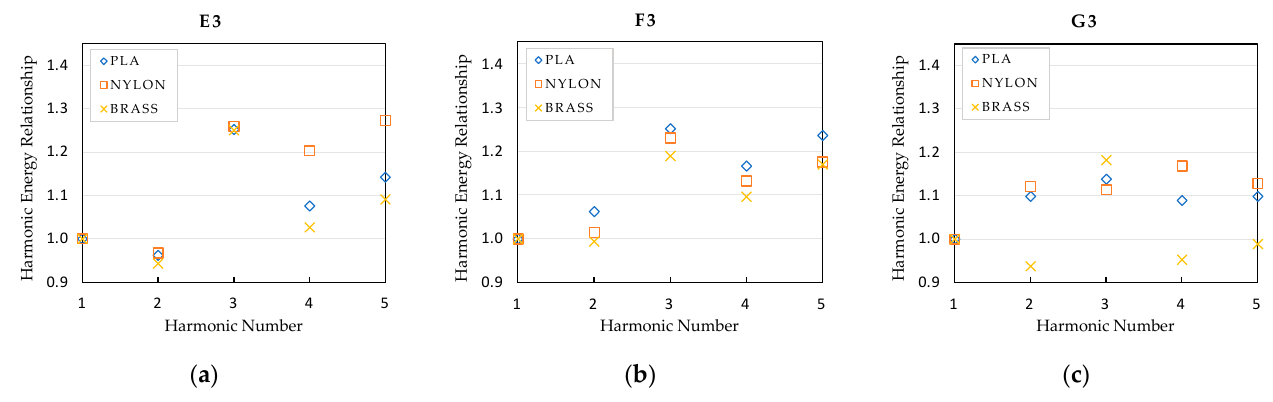
Polymers 2023 , 15 , x FOR PEER REVIEW Figure 12. Harmonic energy relationship of the mid register notes: ( a ) E3 note; ( b ) F3 note; ( c ) G3 Figure 12. Harmonic energy relationship of the mid register notes: ( a ) E3 note; ( b ) F3 note; ( c ) G3 note. Figure 12. Harmonic energy relationship of the mid register notes: ( a ) E3 note; ( b ) F3 note; ( c ) G3 note. note.